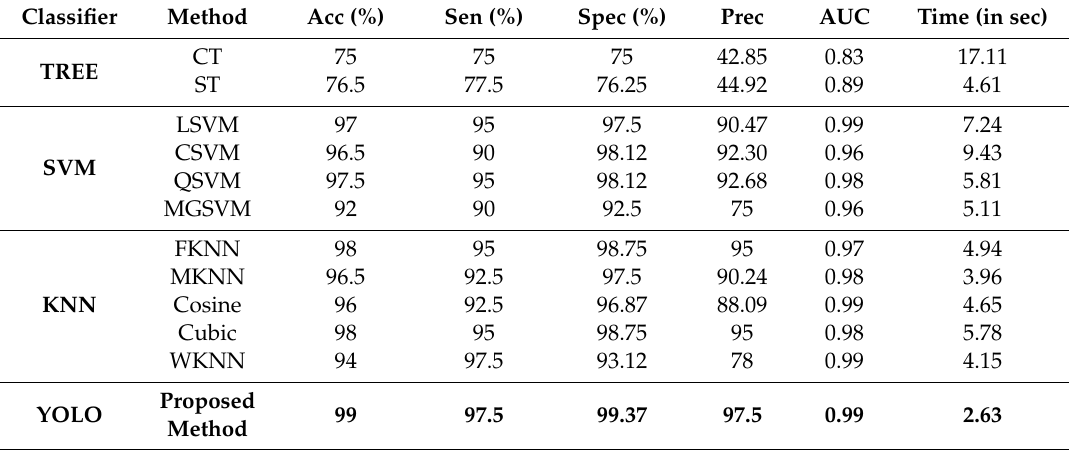
Table 12. Comparative study between proposed classifier and well-known classifiers on PH2 dataset.